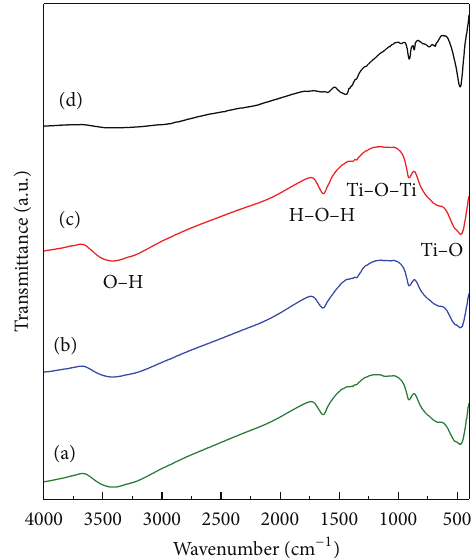
Figure 4: FTIR spectra of the samples prepared at different reaction temperatures: (a) 110 ∘ C, (b) 130 ∘ C, (c) 150 ∘ C, and (d) 180 ∘